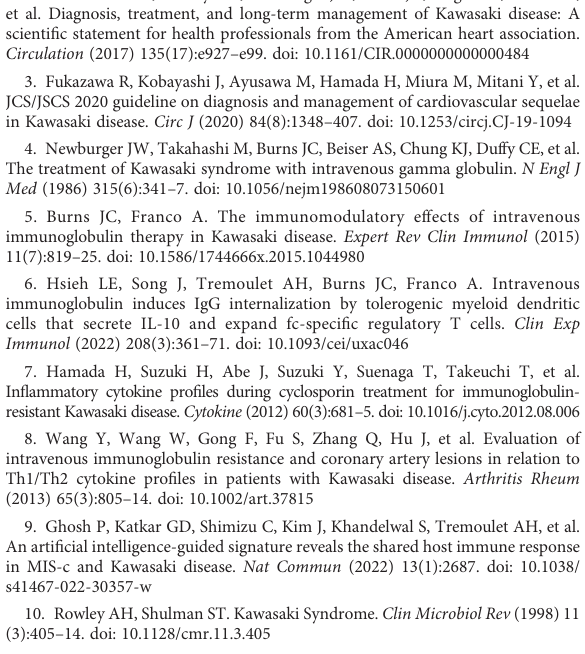
SUPPLEMENTARY FIGURE 3 The cell number of CD69-positive PBMCs from KD patients. (A) The cell number of CD69-positive PBMCs of KD patients in the acute and convalescent phase (n=6) and HV (n=3). The same patient samples are connected by a line. Data are shown as the mean ± SEM. (B) The cell number of white blood cell (WBC, left), neutrophil (Neu, middle), and lymphocyte (Lym, right) of KD patients in the acute and convalescent phase (n=6) and HV (n=3). The same patient samples are connected by a line. Data are shown as the mean ± SEM. SUPPLEMENTARY FIGURE 4 Flow cytometric analysis of peripheral bloods from LCWE-injected mice. (A) Flowcytometry analysisshowing thevariouscellsin thebloodfromthe control mice (n=5) or LCWE-injected mice (day 7) (n=5). We identi fi ed B cells as B220 + CD3 e – cells, T cells as B220 – CD3 e + cells, NK cells as B220 – CD3 e – NK1.1 + cells,NeutrophilsasB220 – CD3 e – CD11b + Ly6G + cells, Eosinophils as B220 – CD3 e – CD11b + Ly6G – Ly6C + SSC hi cells, Ly6C + or Ly6C – Monocytes as B220 – CD3 e – CD11b + Ly6G – SSC low cells. Data are shown as the mean ± SEM. (B) The graph showing the frequency (left) and the absolute numbers in 100ml of peripheral blood (right) of each cells that identi fi ed in (A) . (C) The graph showing the frequency (left) and the absolute numbers in 100 m l of peripheral blood (right) of CD69 positive each cells that identi fi ed in (A) . Data are shown as the mean ±